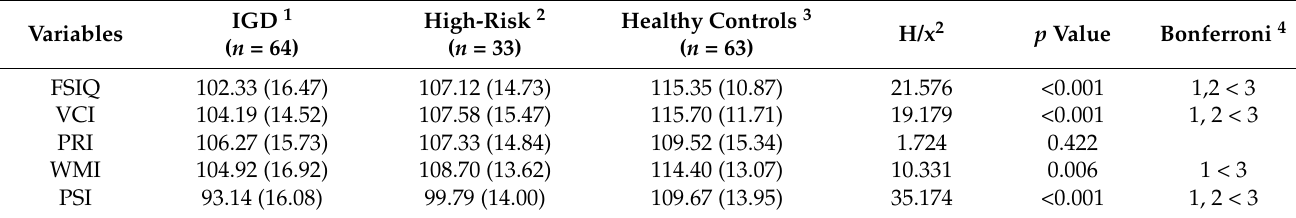
Table 3. Comparison of intelligence level among three groups ( n = 160).